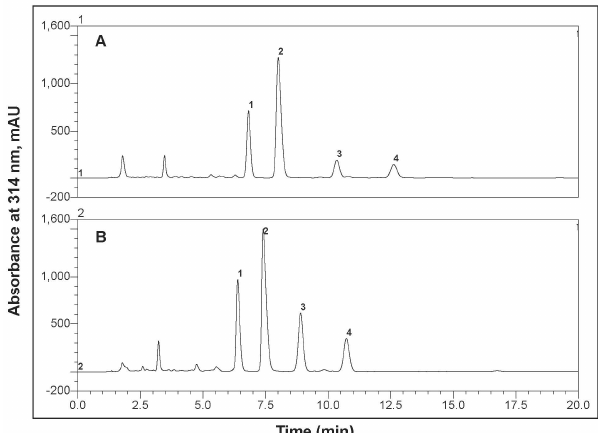
Figure 1. Bitter acid profiles of stored Galena ( A ) and Chinook ( B ) hops. Extracted samples were separated on a C18 column using a water-methanol-phosphoric acid mobile phase. Eluting compounds were detected at 314 nm. The peaks shown correspond to co-humulone (1), ad-humulone + humulone (2), co-lupulone (3) and ad-lupulone + lupulone (4). Standards were injected at the beginning, middle, and end of each series of sample injections to verify shifting retention times.